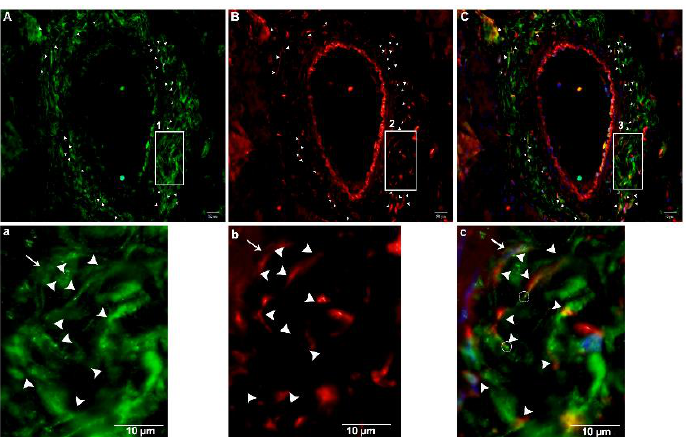
Figure 13. Immunofluorescence-positive telocytes in the connective tissue surrounding large blood vessels. Immunofluorescence CD34+ is shown in green in ( A ), Vimentin+ in red in ( B ), and merged in ( C ), and labeled. Tps were abundantly distributed around the large blood vessels (arrowheads). The square-marked areas 1, 2, and 3 in ( A , B , C ) are enlarged in ( a , b , c ), respectively. TCs with Tps and long processes close to the other telopodes can be seen. ( c ) Podom, marked as a bright spot (circle), the nucleus (arrow), and the processes (arrowheads) are all visible. Scale bar = 20 µm in ( A – C ); scale bar = 20 µm in ( a – c ).